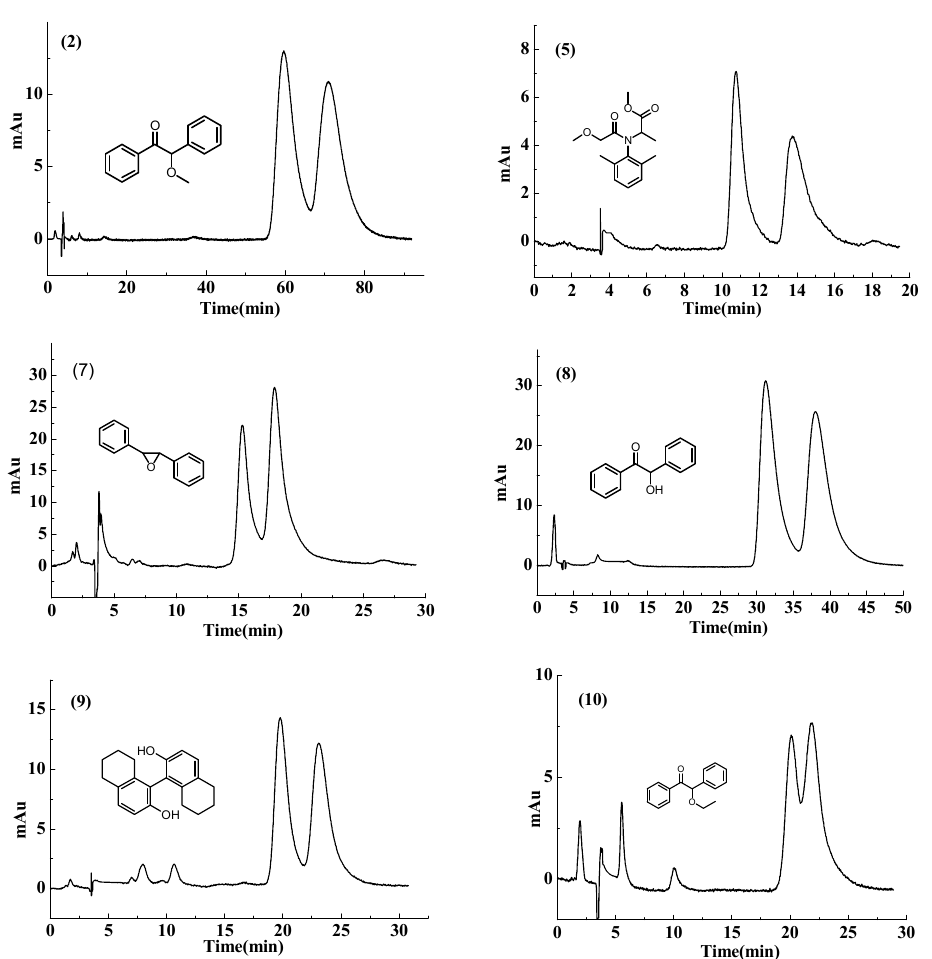
Figure 4. Chiral separation chromatograms of racemates on CPM2 column under reversed phase mode. ( 2 ) benzoin methyl ether; ( 5 ) metalaxyl; ( 7 ) trans -stilbene oxide; ( 8 ) benzoin; ( 9 ) octahydro binaphthol; ( 10 ) benzoin ethyl ether. Chromatographic conditions: mobile phase; ( 2 , 8 , 10 ) acetonitrile/water (15/85, v / v ); ( 5 , 7 ) acetonitrile/water (20/80, v / v ); ( 9 ) acetonitrile/water (30/70, v / v ). Flow rate, 0.6 mL/min. Detection wavelength, 254 nm. Temperature, 25 °C.